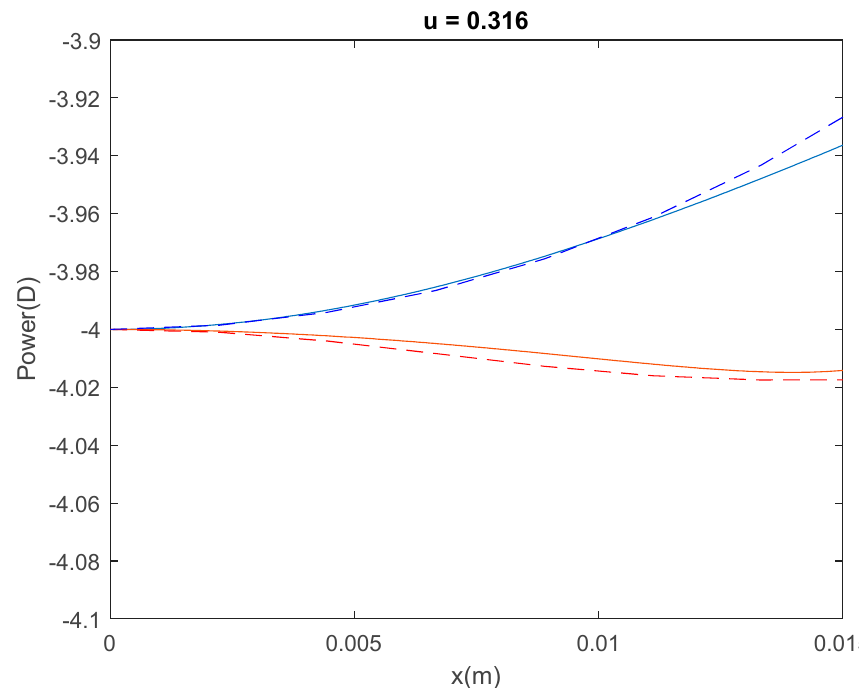
Figure 9. Tangential (red line) and sagittal (blue line) powers up to the term c 8 for a lens with = 37 D. The continuous lines represent the analytical P = − 4 D, B = 0.5 D, n = 1.5, and L (cid:48) 2 solution obtained with the approximation described in the text for u = 0.316, while the dashed lines correspond to the oblique power of the lens computed by multiparametric minimization of the merit function (39) with weights ( 1,1,0,0 )